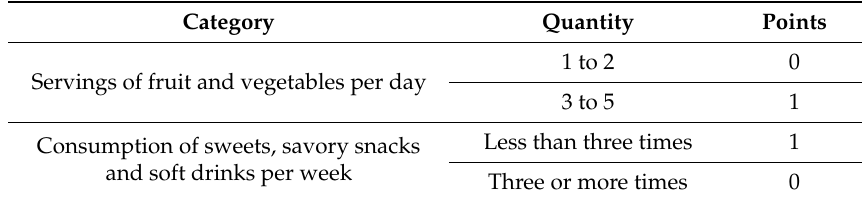
Table 2. Definition of the points obtained with the answers about the consumption of fruit and vegetables, and sweets, savory snacks, and soft drinks.